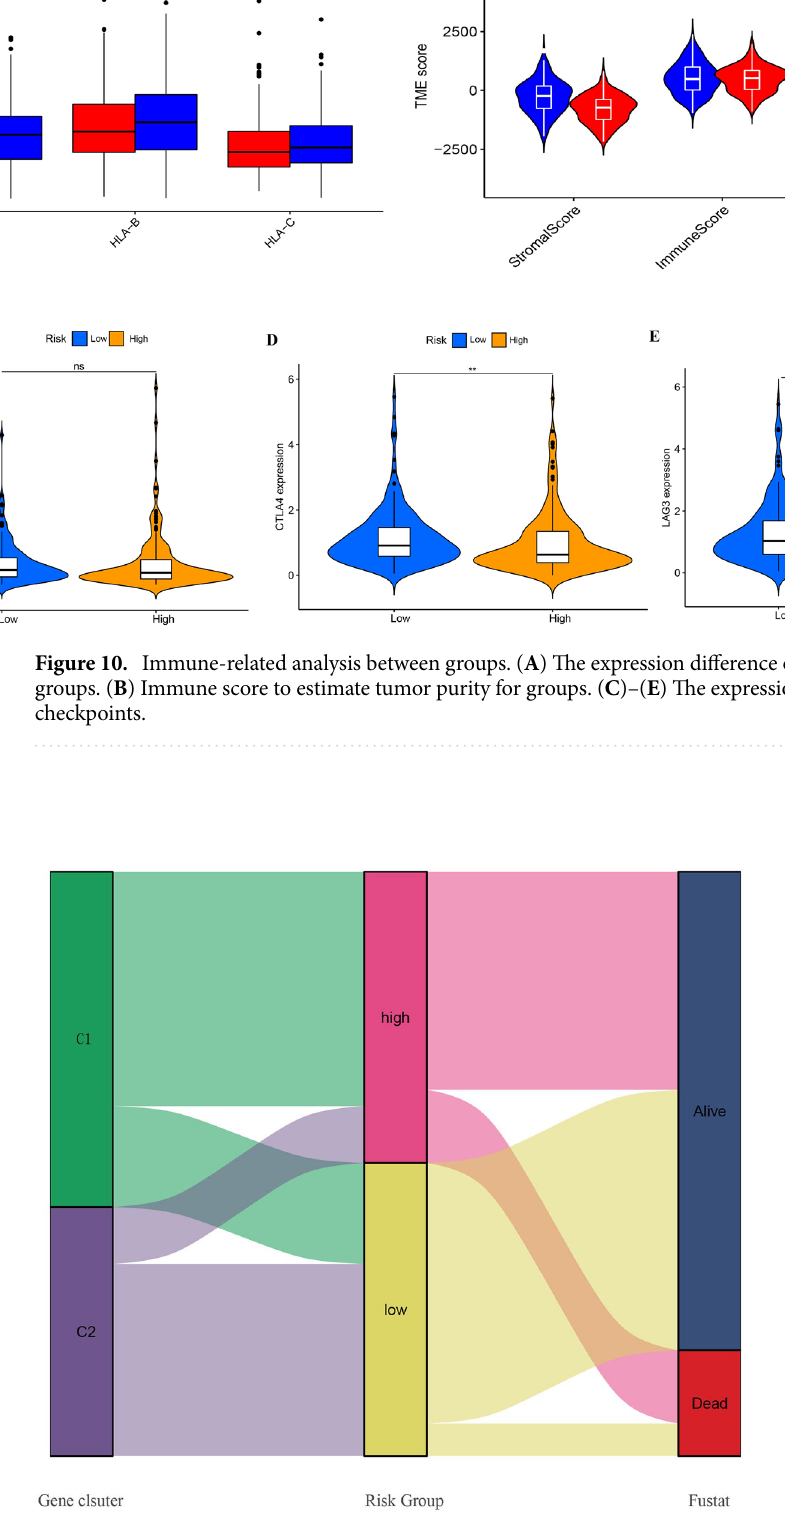
Figure 11. Sankey diagram was performed to present the relationship among clusters, risk groups and